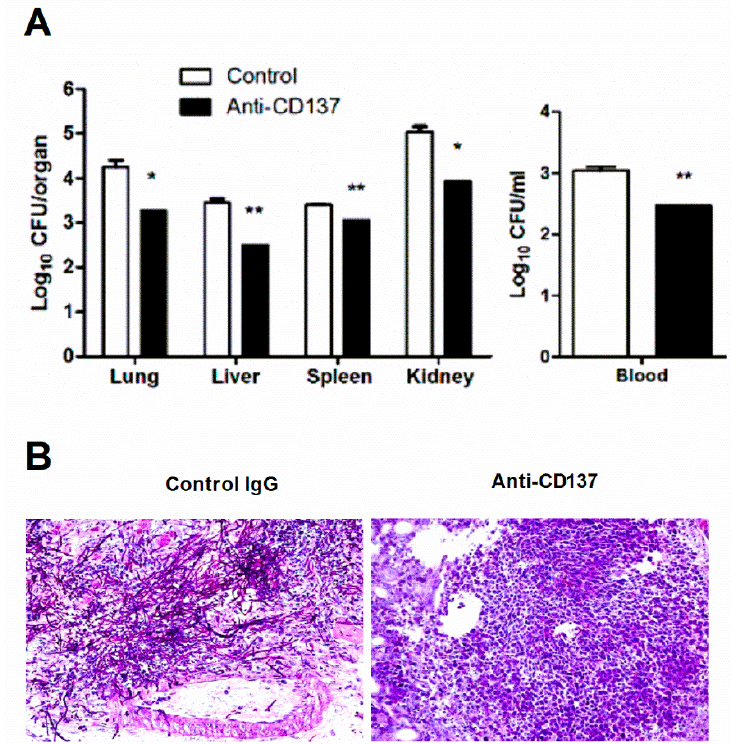
Figure 2. CD137 stimulation inhibits the outgrowth of C. albicans . ( A , B ) Mice were intraperitone- ally injected with 200 μ g of anti-CD137 or control rat IgG antibody 1 day before infection with 3 × 10 5 CFU of C. albicans . Organs were harvested at 3-d post-infection. ( A ) Counting of CFUs (n = 5 mice per group). ( B ) PAS staining of kidney sections. Magnification: 200×. Results are representative